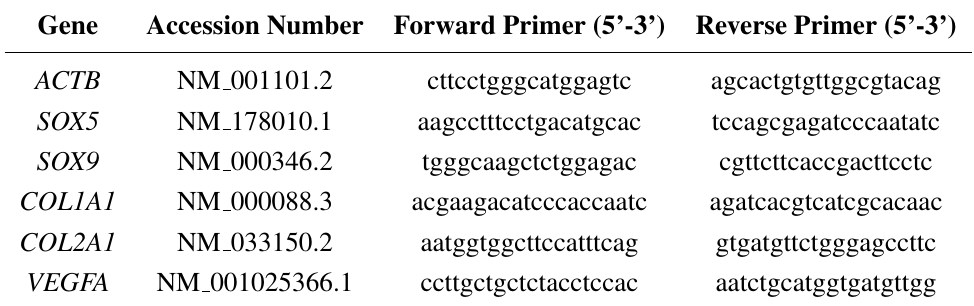
Table 1. Sequences of primers used in real-time RT